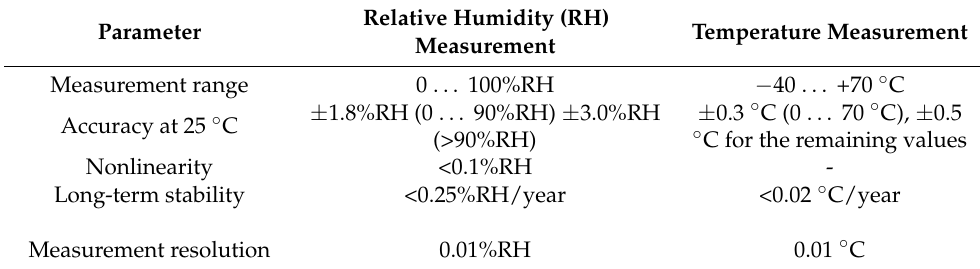
Table 1. Technical data of the digital temperature and relative humidity sensor.